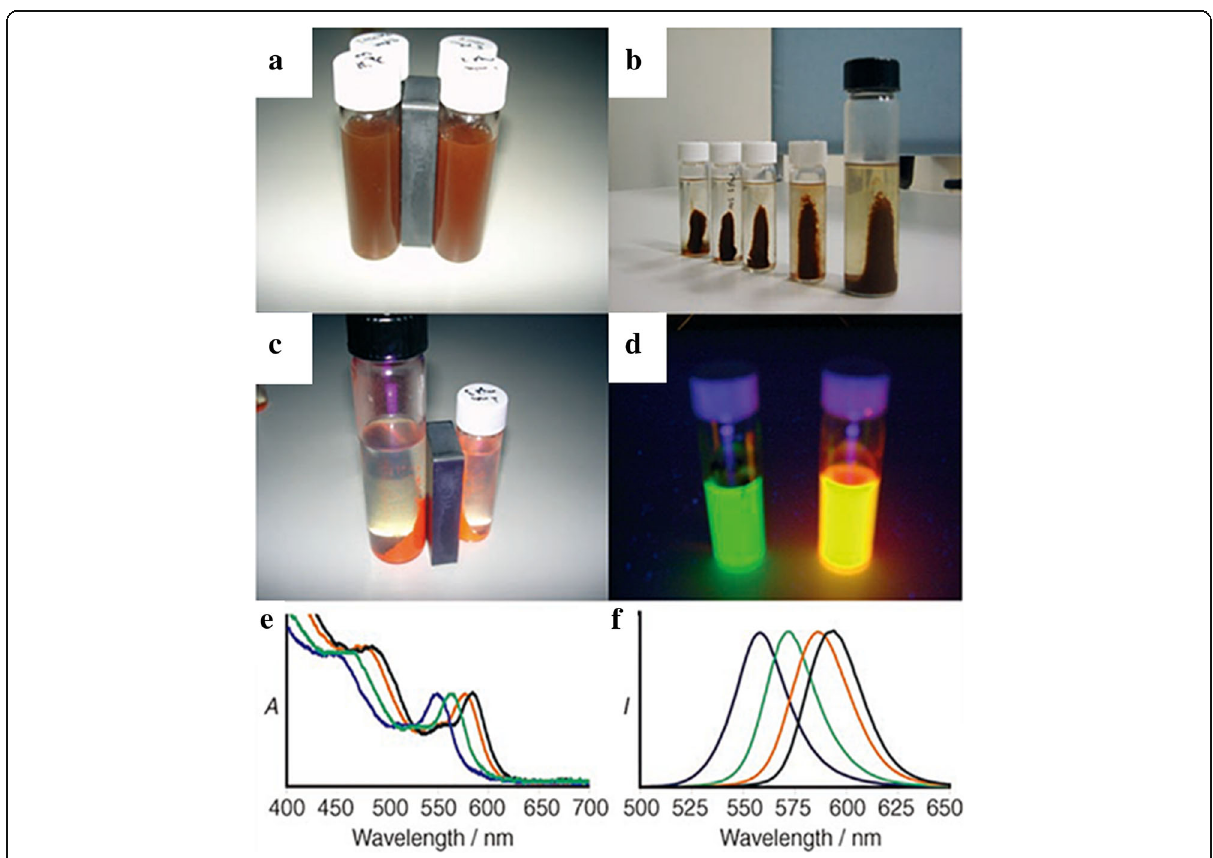
Fig. 9 The photographs under normal light to prove the magnetic modification ( a , b ). c The photograph under UV light to prove both the magnetic and luminescence properties. d The UV photograph of green and orange magnetic quantum dots (MQDs). e , f The luminescence spectra of SiO 2 -MQDs in PBS solutions ( e for absorption and f for emission)